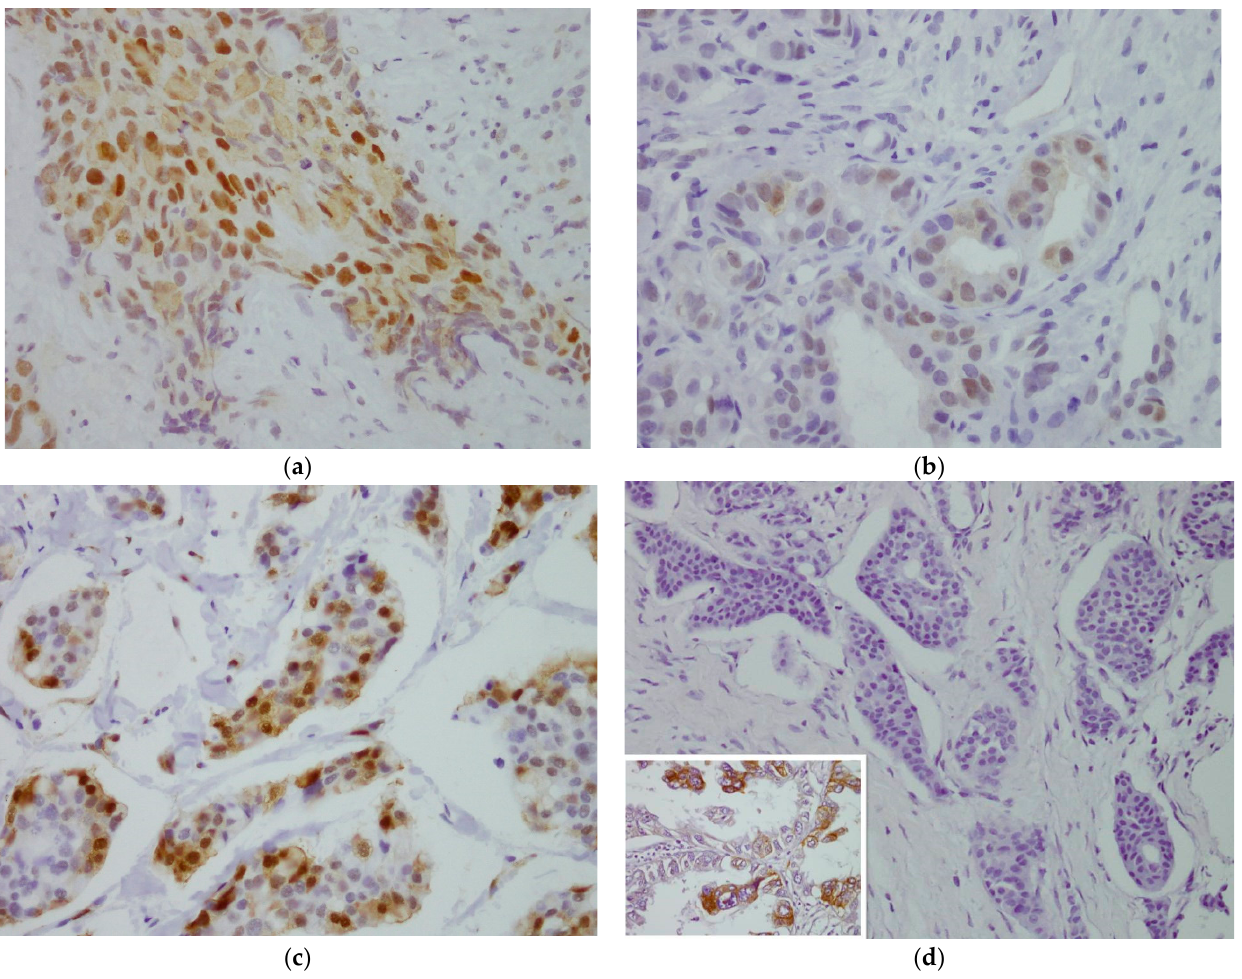
Figure 1. Evaluation of immunohistochemical staining. ( a ) For HIF-1 α , moderate staining of nuclei and slight staining of some cytoplasmic areas, >5% in tumor cells. 40 × . ( b ) For pAKT, mild-to-moderate nuclear and cytoplasmic staining, ≥ 10% in tumor cells. 40 × . ( c ) For pMAPK, strong nuclear staining and mild-to-moderate cytoplasmic staining, >10% in tumor cells. 40 × . ( d ) For EGFR, negative membrane staining. A staining positive control for EGFR of lung cancer was inserted in the image 40×.